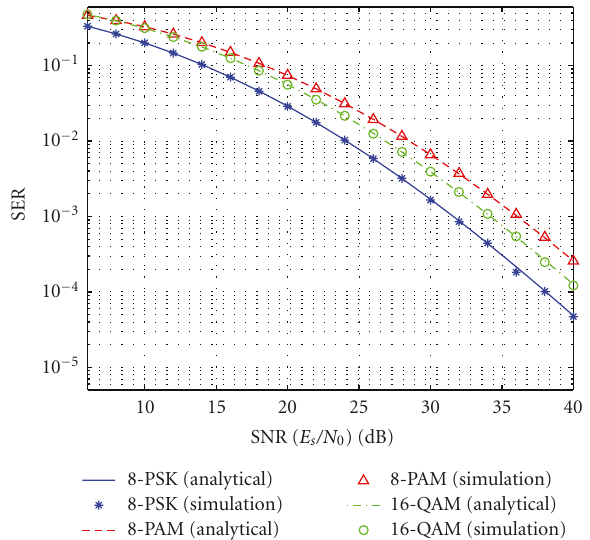
Figure 2: Comparison of SER computed using analytical expres- sions (21), (22), and (23) with the estimates obtained by system simulation. Results obtained with a 2 × 2 MIMO system (without precoding) based on rate 1 OSTBC G 2 (Alamouti code) [19] and the exponential antenna correlation model.